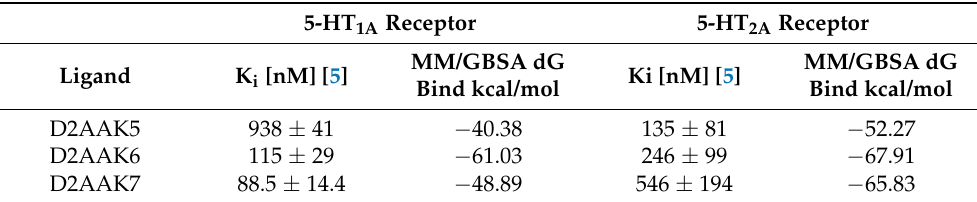
Table 2. Affinity of the studied ligands and MM/GBSA binding energy to serotonin 5-HT 1A and 5-HT 2A